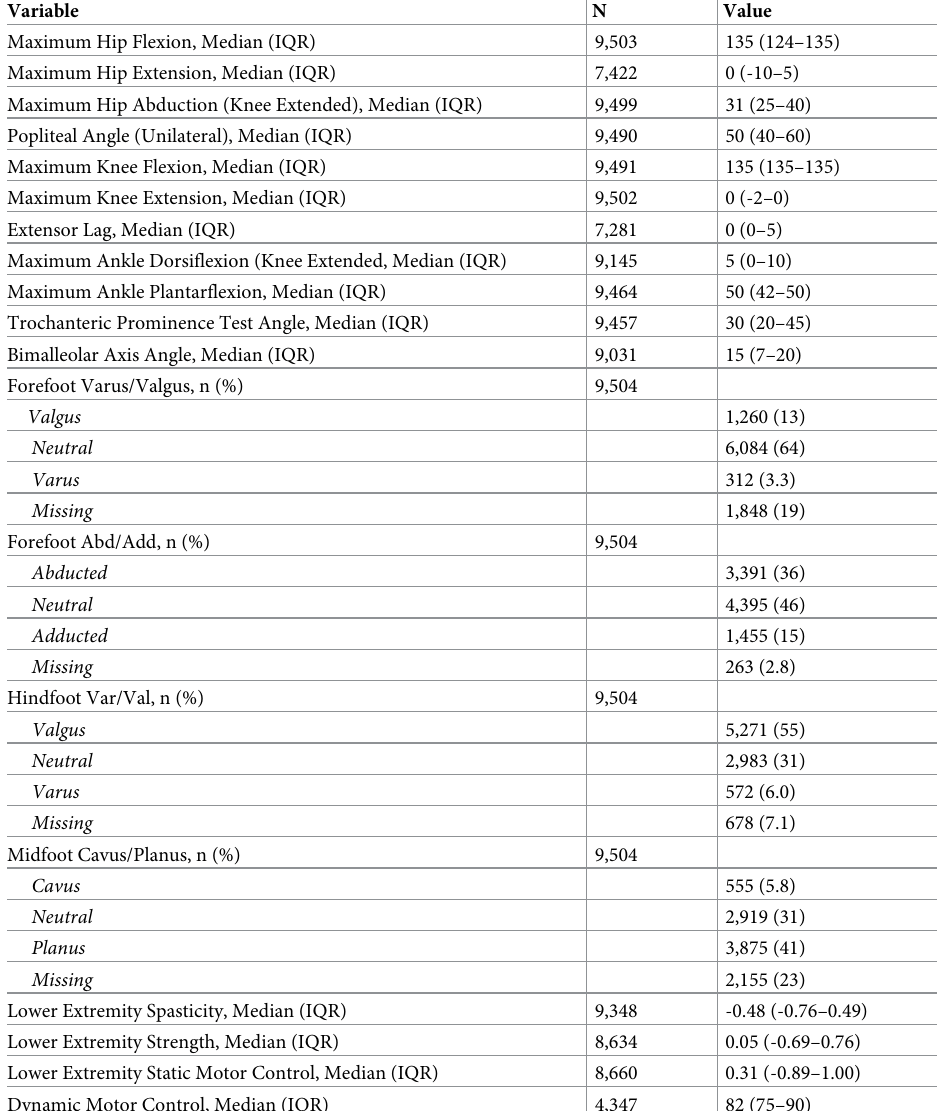
Table 3. Structure and